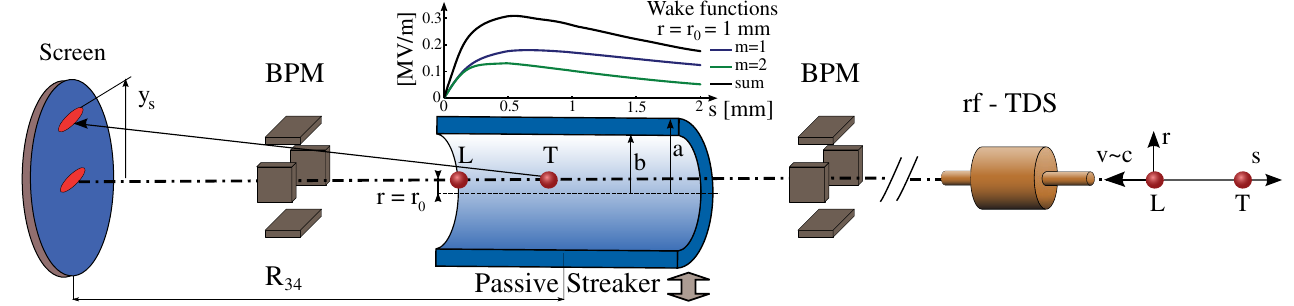
FIG. 1. Schematic layout of the dielectric-lined waveguide ( passive streaker ) used for the experiment at SITF. L is the leading particle that travels along the cylindrical waveguide at an offset r 0 , T is the trailing particle with an offset r